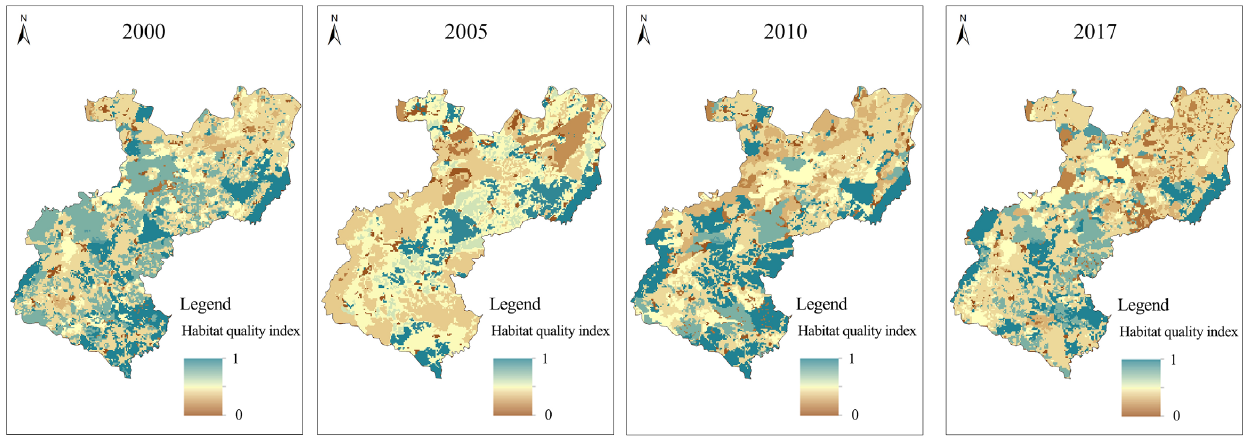
Figure 8. Habitat quality change in the study area from 2000 to